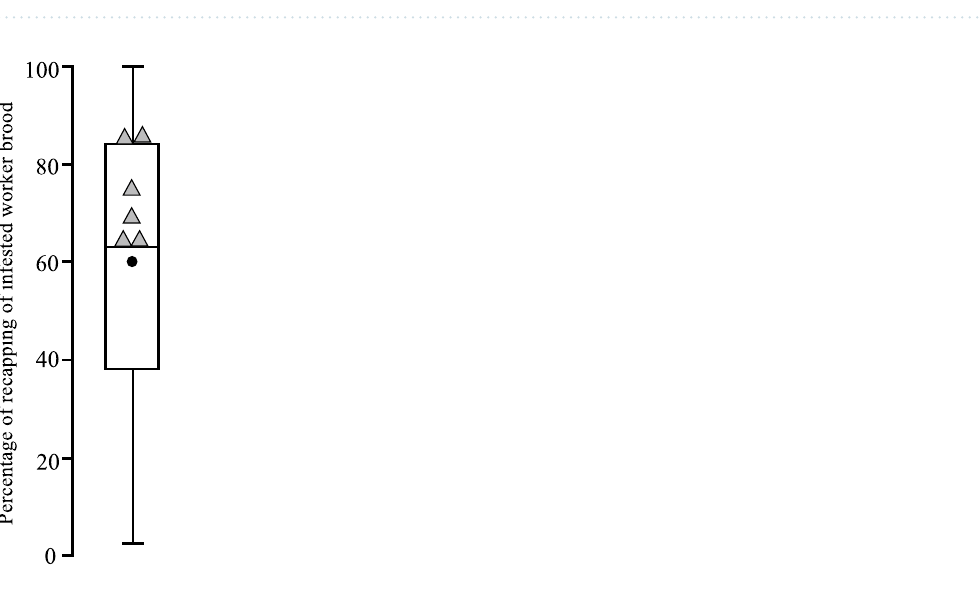
Figure 1. Recapping rates from both worker and drone showing levels in non-infested (yellow) or infested (red) cells from this (in bold) and previous studies 4,5,9 .